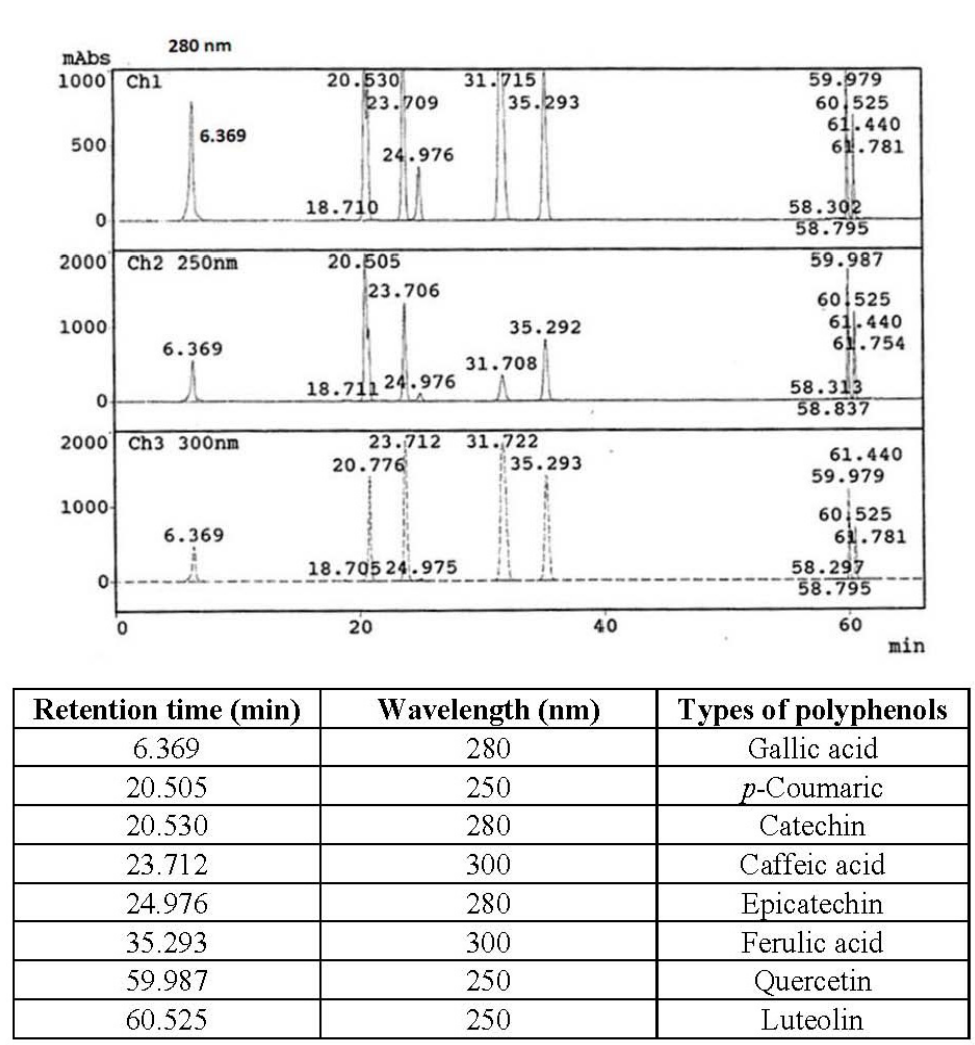
Figure 1. Polyphenols mixed standard of